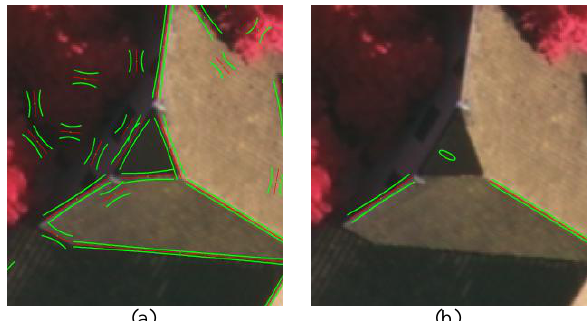
Fig. 4 (a) Confidence regions of extracted line segments, (b) an example of the generated artificial intersection point and its elliptical confidence region. Entities and confidence regions are shown in red and green colors, respectively. Confidence regions are 15 times exaggerated for visualization.